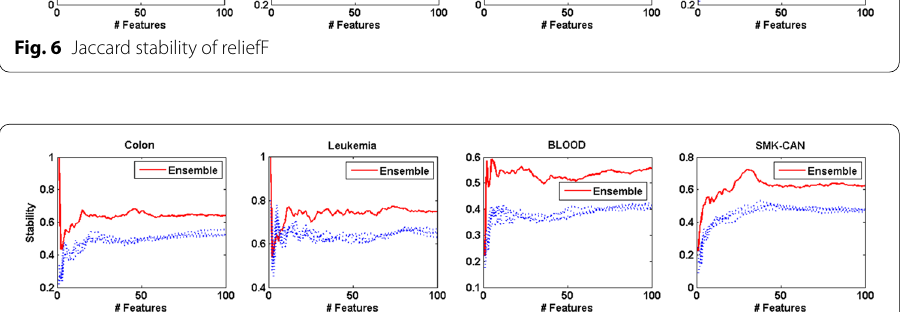
Fig. 7 Jaccard stability of ℓ 1